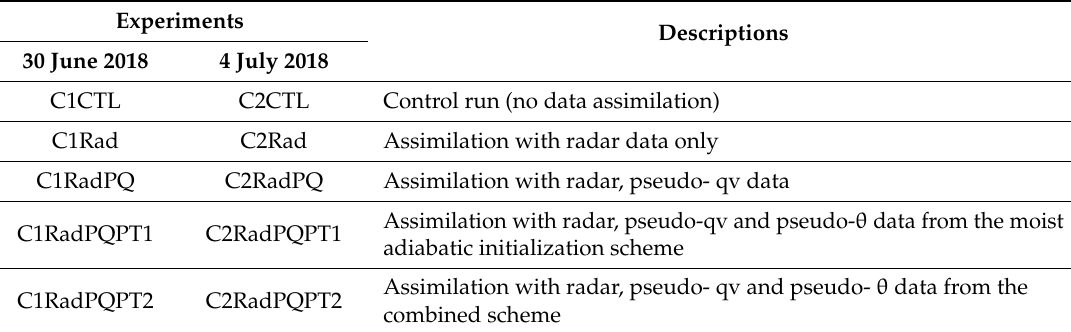
Figure 2. The model domain and locations of the radar stations for the two real cases, on 30 June 2018 and 4 July 2018. The white box indicates the model domain (same size as in Figure 4). The black dots represent locations of radar stations and maximum range of each radar is shown by the white circle. For both cases, 25 radar stations are used. Table 1. The acronyms and descriptions of the simulation